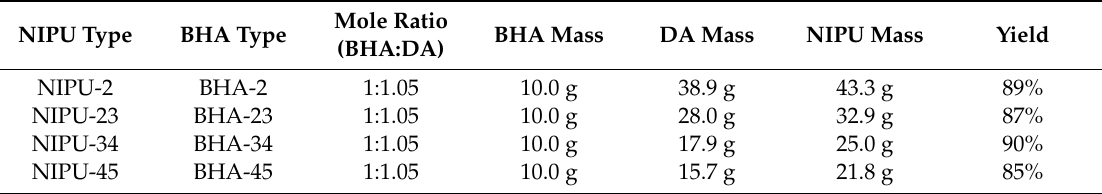
Table 2. The raw material mass and results of the